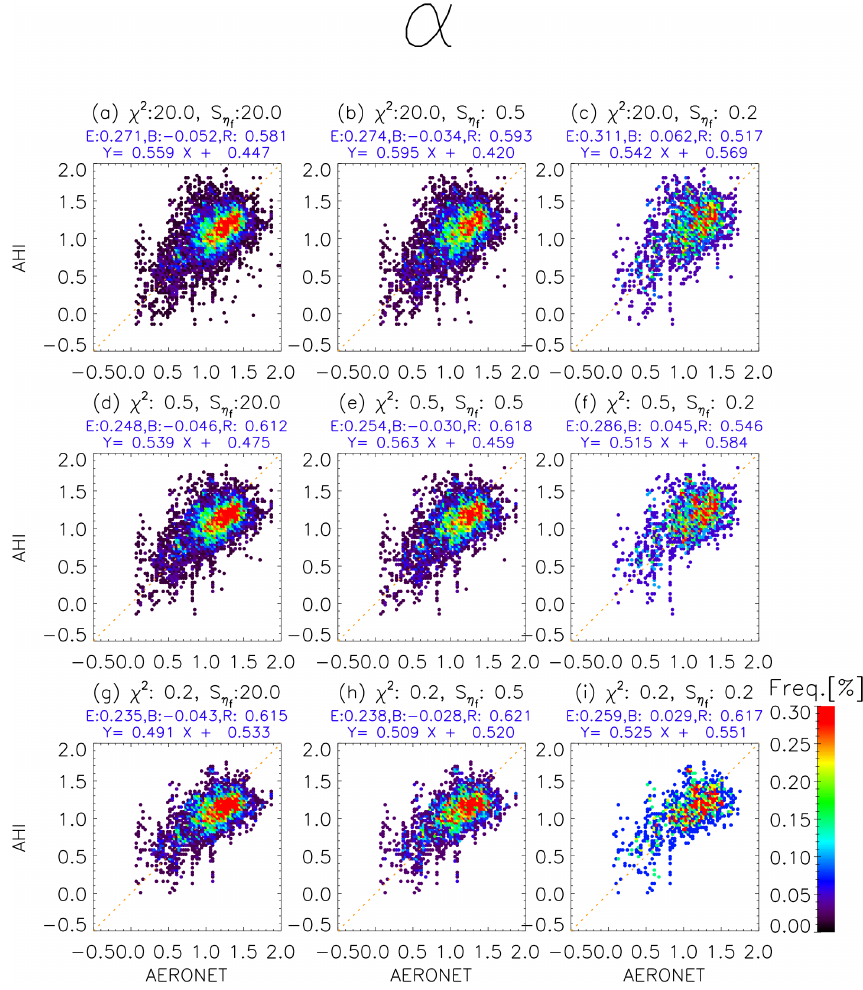
Figure 9. Frequency distribution of α retrieved from AHI and those from AERONET. The results retrieved from this algorithm in the case of χ 2 less than 20, 0.5, and 0.2 and uncertainties of the retrieved η f ( S η above the figures are the same as in Fig.